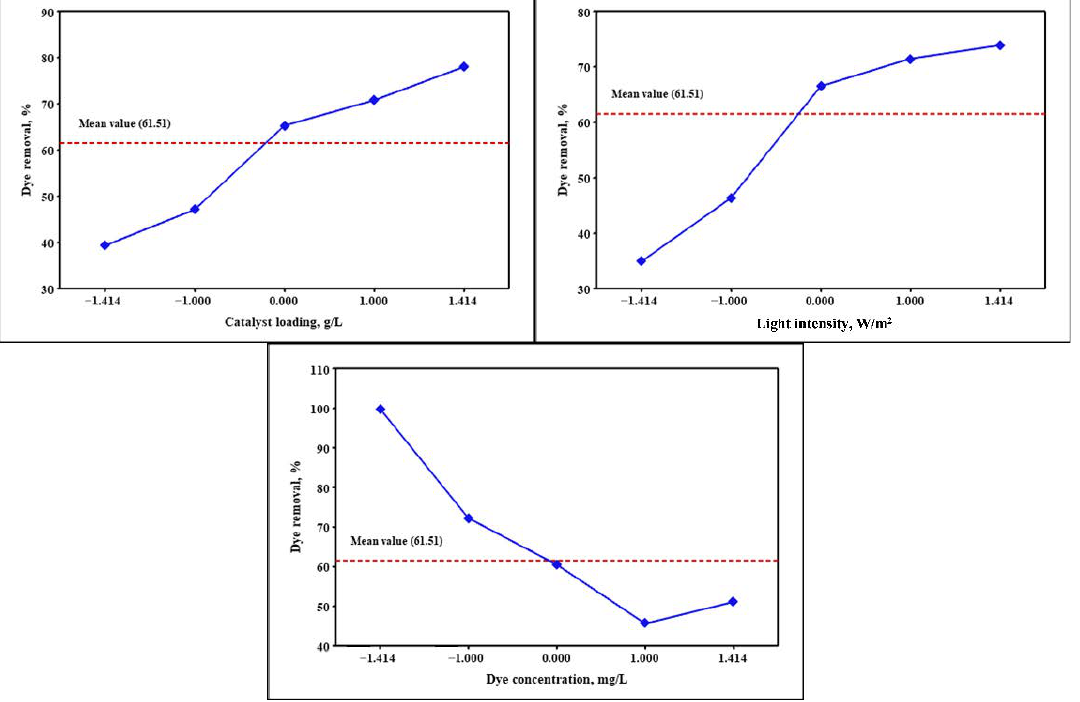
Figure 4. Main e ff ects of three input variables (dye concentration, catalyst loading, and light intensity) on DB15